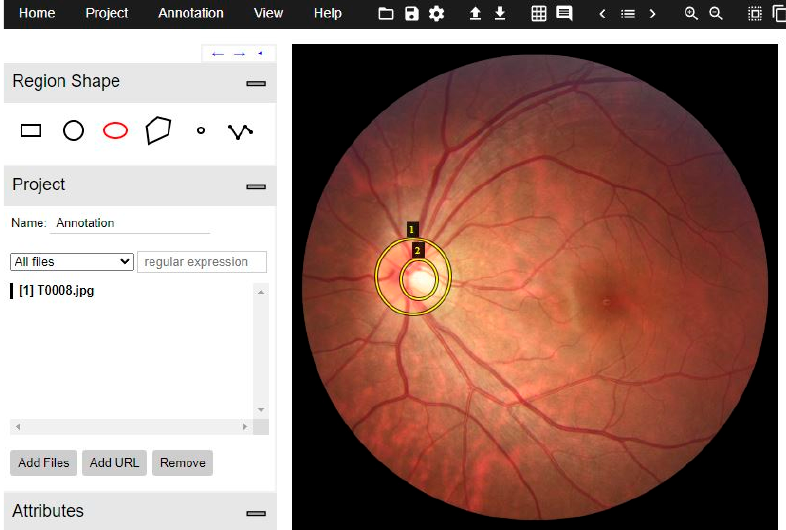
Figure 4. Annotation example of REFUGE image. The elliptic shape was selected. Number one annotates to disc class, and annotation two corresponds to cup class.